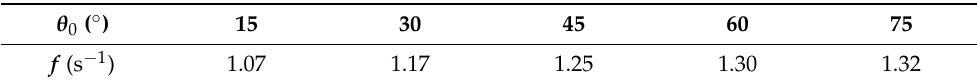
Table 4. Values of the Brunt–Väisälä frequency f during the simulation cycles for each inclination angle